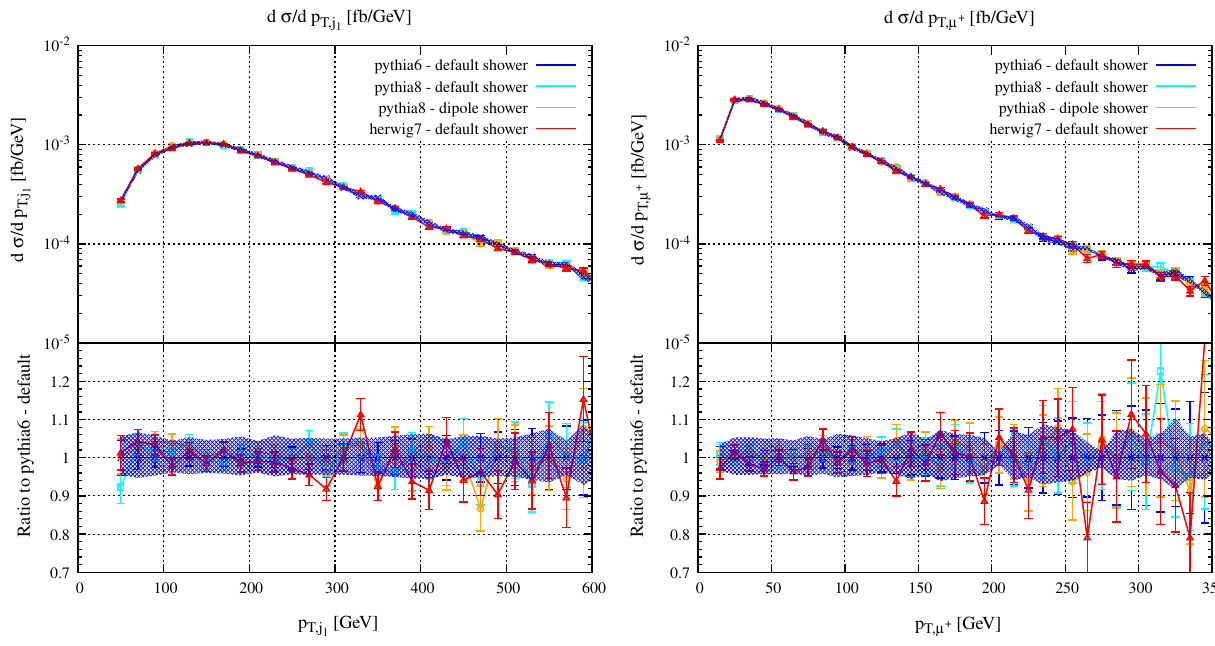
Fig. 1 Transverse-momentum distributions of the hardest tagging jet (left) and of the positively charged muon (right) in the CMS-tight sce- nario. In the lower panels the ratio of the respective distribution to